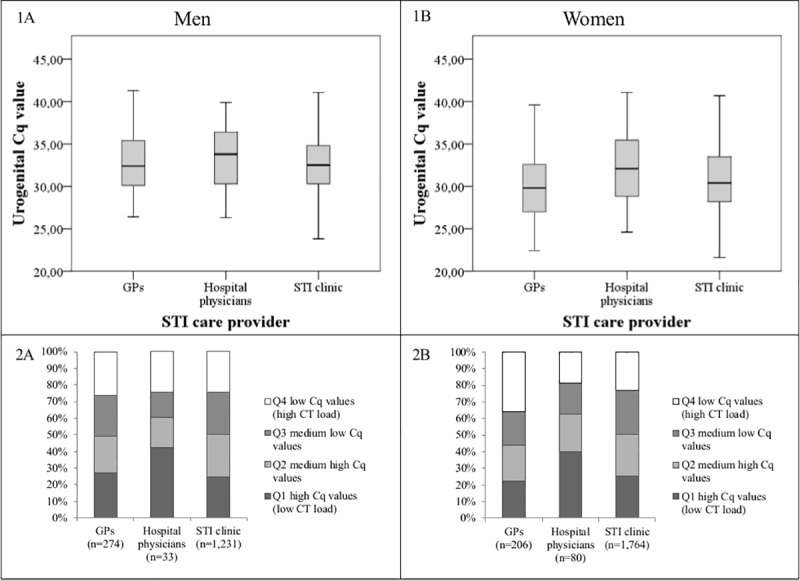
Boxplots and bar diagrams showing the distribution of high- and low Cq values for the GP, hospital and STI clinic population.(1) Boxplots showing the distribution of urogenital Cq values between the GP, hospital physicians and STI clinic population for men (A) and women (B). (2) Bar diagrams showing the frequencies of low (high CT load), medium low, medium high and high (low CT load) urogenital Cq values based on quartiles per STI provider for men (A) and women (B).